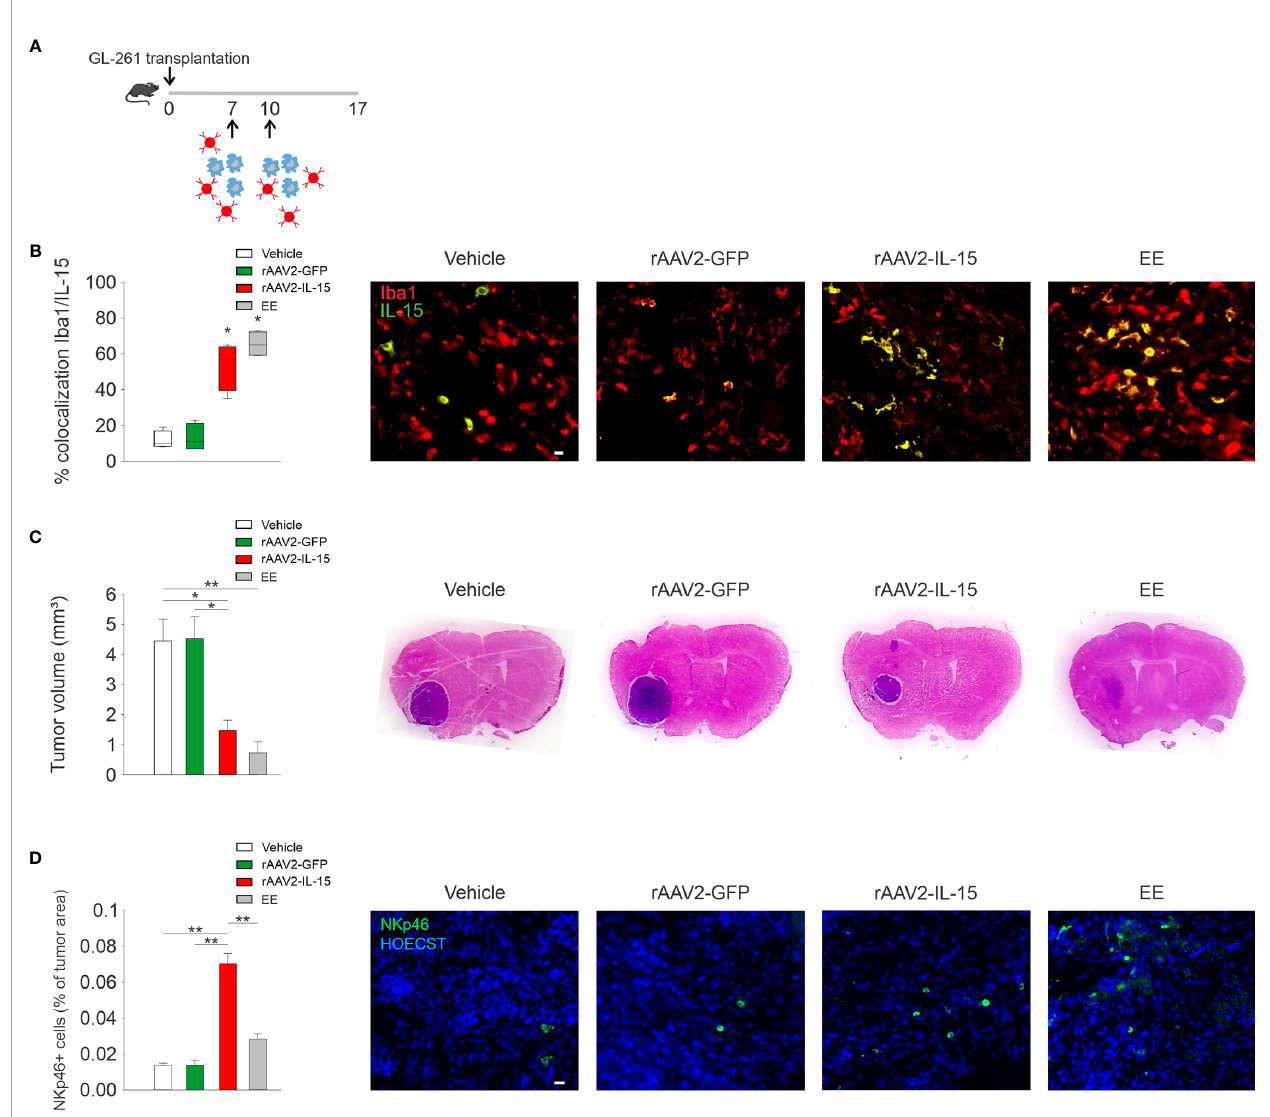
FIGURE 3 | rAAV2-IL-15-microglia increase NK cell accumulation and reduce glioma volume. (A) Scheme of intranasal delivery of rAAV2-IL-15 microglia in GL261- transplanted mice. (B) Colocalization of IL-15- and Iba1-covered areas in tumor mass in mice i.n. treated with rAAV2-GFP or rAAV2-IL-15 microglia (n = 4 data are the mean ± s.e.m. *p < 0.05 Student ’ s t-test). For boxplots, the center line, boxes, and whiskers represent the median, inner quartiles, and the rest of the data distribution, respectively. Right: representative immuno fl uorescence of Iba1+ cells (red) and IL-15+ cells (green). Scale bar: 20 µm. (C) Tumor volume in murine GL261-bearing mice treated i.n. with vehicle, rAAV2-GFP, or rAAV2-IL-15 microglia, or exposed for 5 weeks in EE as indicated. Tumor volumes were measured 17 days after implantation of glioma cells into the striatum of C57BL/6 mice (n = 4-7, data are the mean ± s.e.m. *p < 0.05, **p < 0.01 one-way ANOVA). Right: representative coronal section of glioma-bearing mice stained with H&E. (D) Analyses of NKp46+ cell in fi ltration in tumor, expressed as % NKp46 cells in the tumor area (± s.e.m.; *p < 0.05 one-way ANOVA; n = 4 mice per condition). Representative immuno fl uorescence of NKp46 cells (green) 17 days after GL261 cell transplantation in mice treated i.n. with rAAV2- GFP or rAAV2-IL-15 microglia are shown on the right. Scale bar: 20